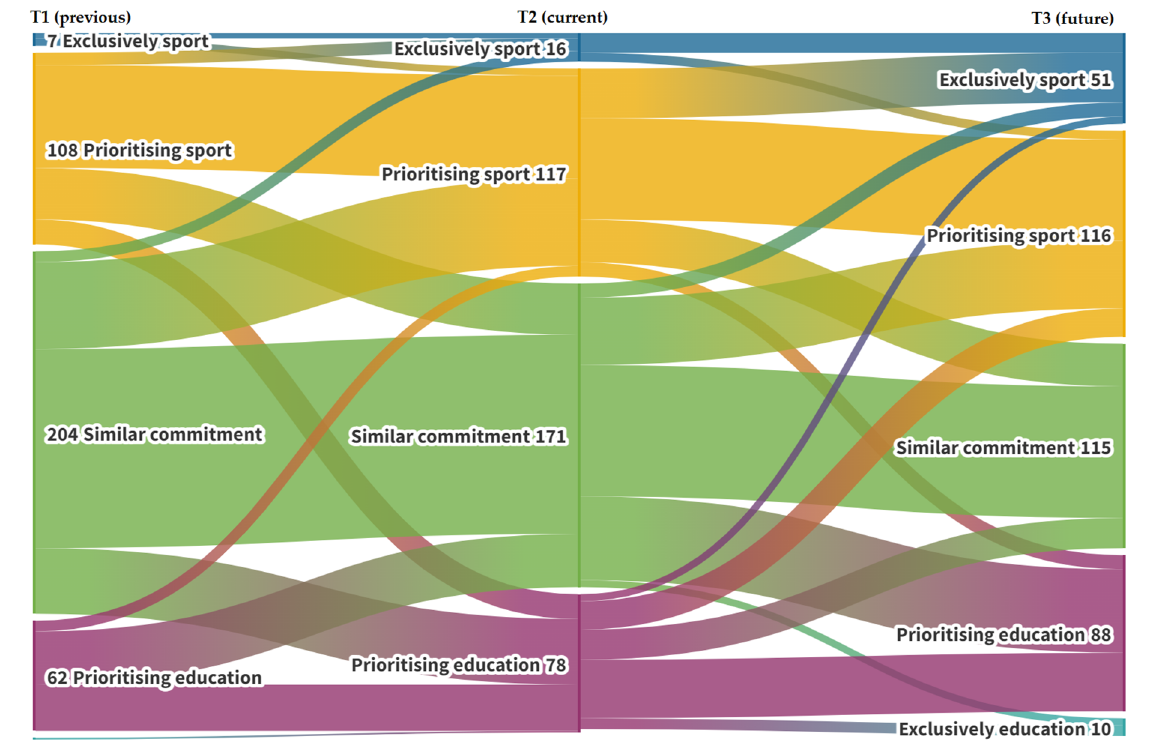
Figure 1. Sankey diagram of the evolution of prioritization for sports and education among talented athletes. Note : T1, time 1; T2, time 2; T3, time 3.